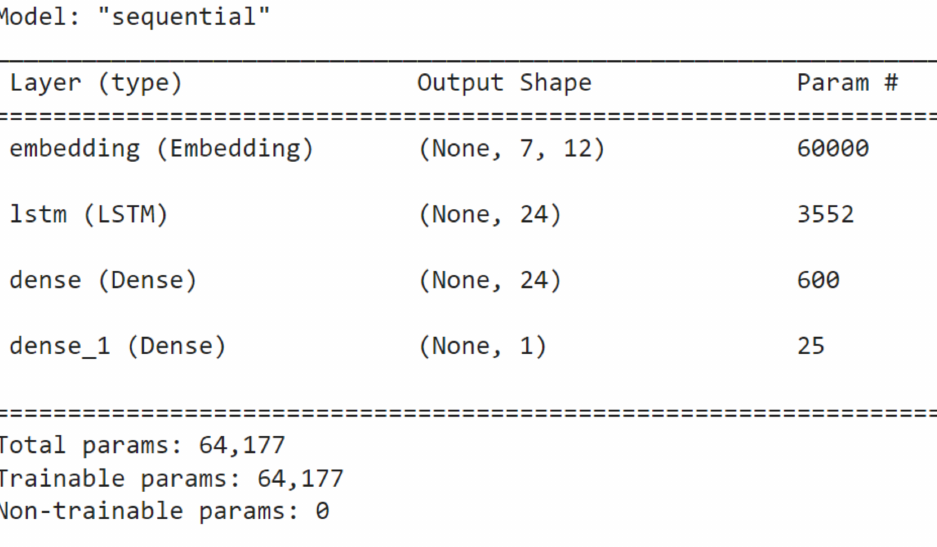
Figure 6. GRN architecture for